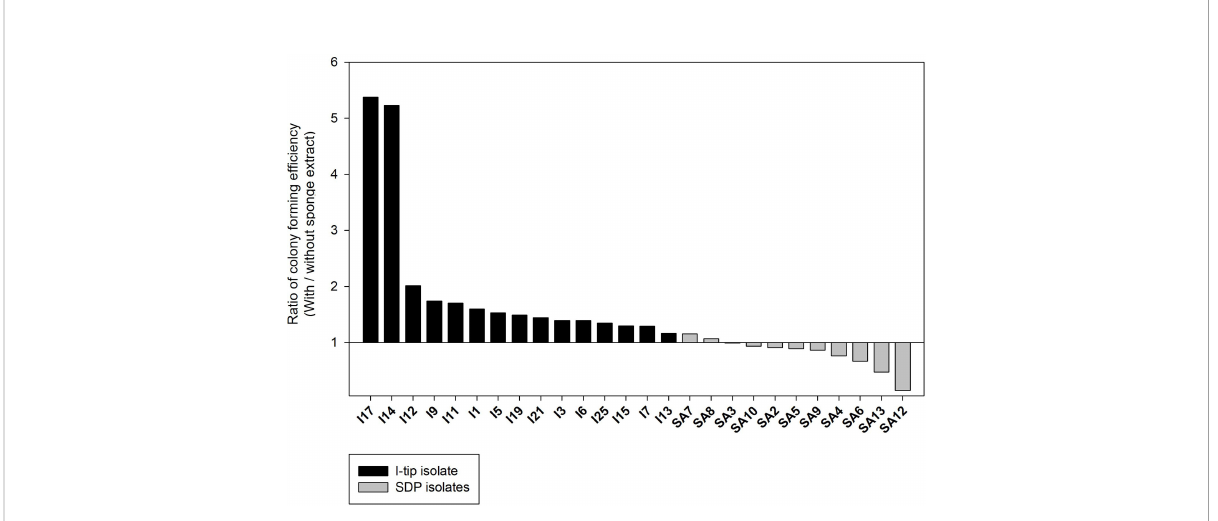
FIGURE 9 The effect of sponge extract on cell recovery rate of I-tip and SDP (standard direct plating) strains. The ratio of colony forming numbers between the two culture conditions (colony numbers on the agar medium with the sponge extract/colony numbers on the agar medium without the sponge extract) was calculated for each selected strain. The ratio was calculated using the average value from triplicate measurements (n=3) of the CFUs on each agar plate. Data for SDP strains have already been reported (Jung et al.,